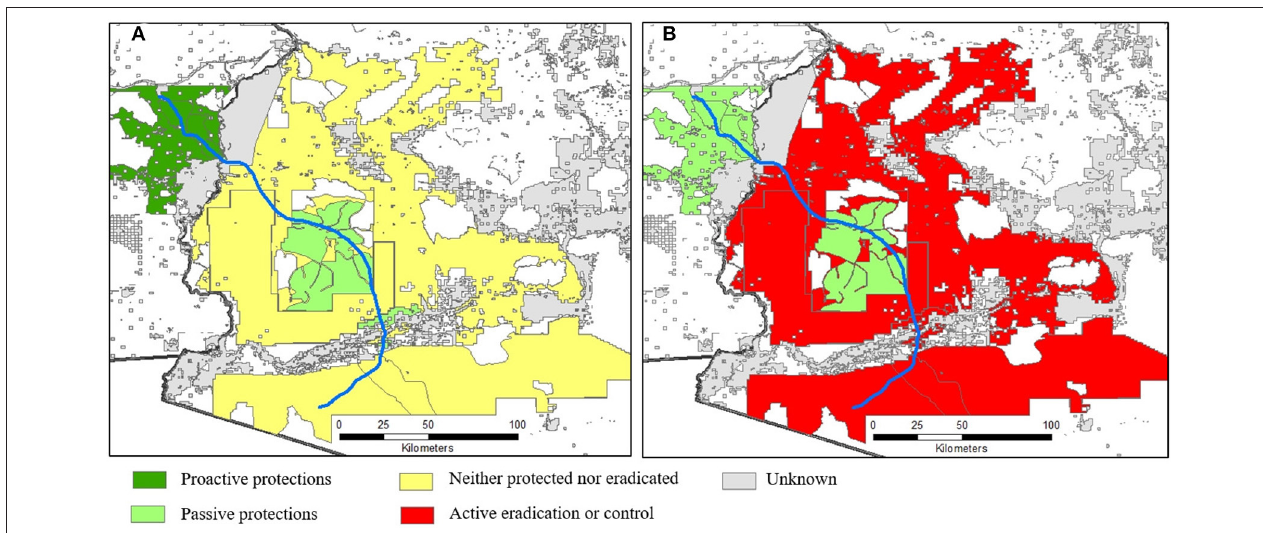
FIGURE 3 | Regulatory status of Harwood’s woolly star in jurisdictions along a plausible climate-driven migration route (blue line): (A) Under the most protective interpretation of relevant regulatory language; (B) Under the most restrictive interpretation of relevant regulatory language (see Supplementary Table 1